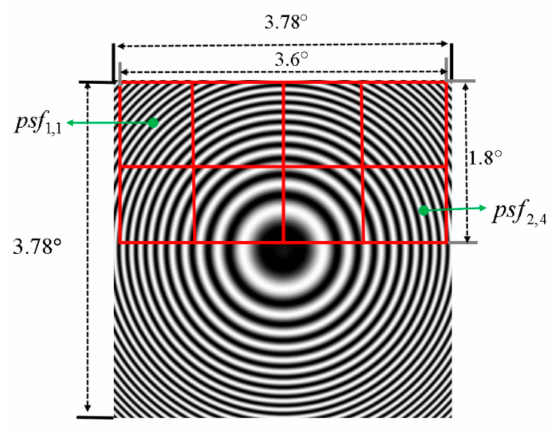
Figure 4. The calculation of point spread functions